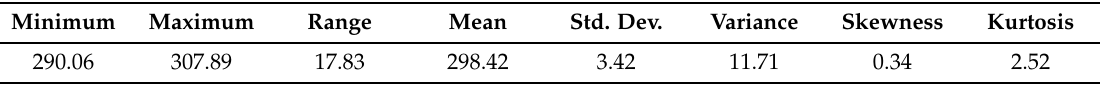
Figure A4. Histogram plot of the air outlet temperature measured using “Hobo” sensors, within the 7688 data sets collected by SRNL from F-Area cooling towers (unsaturated conditions). Table A3. Air outlet temperature distribution statistics [K], measured using “Hobo” sensors. Minimum Range